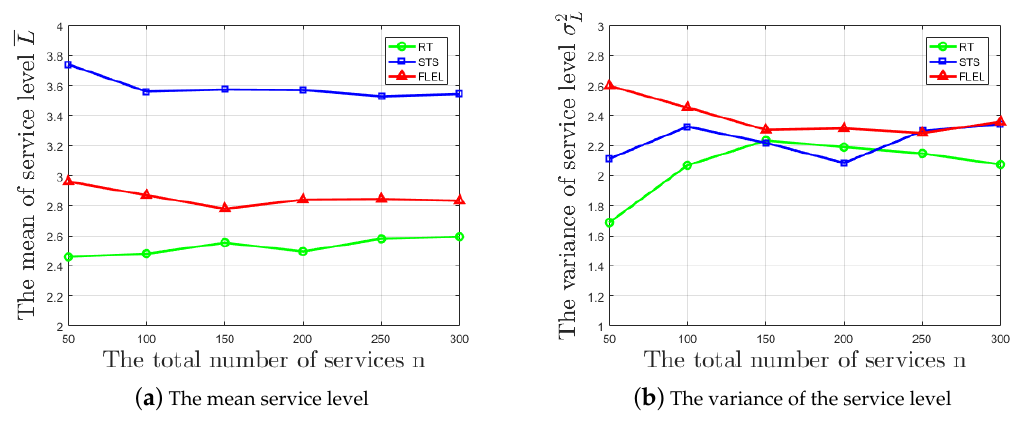
Figure 4. The changing of the service level with respect to different amounts of service. RT, Randomization Test; STS, Single Test in